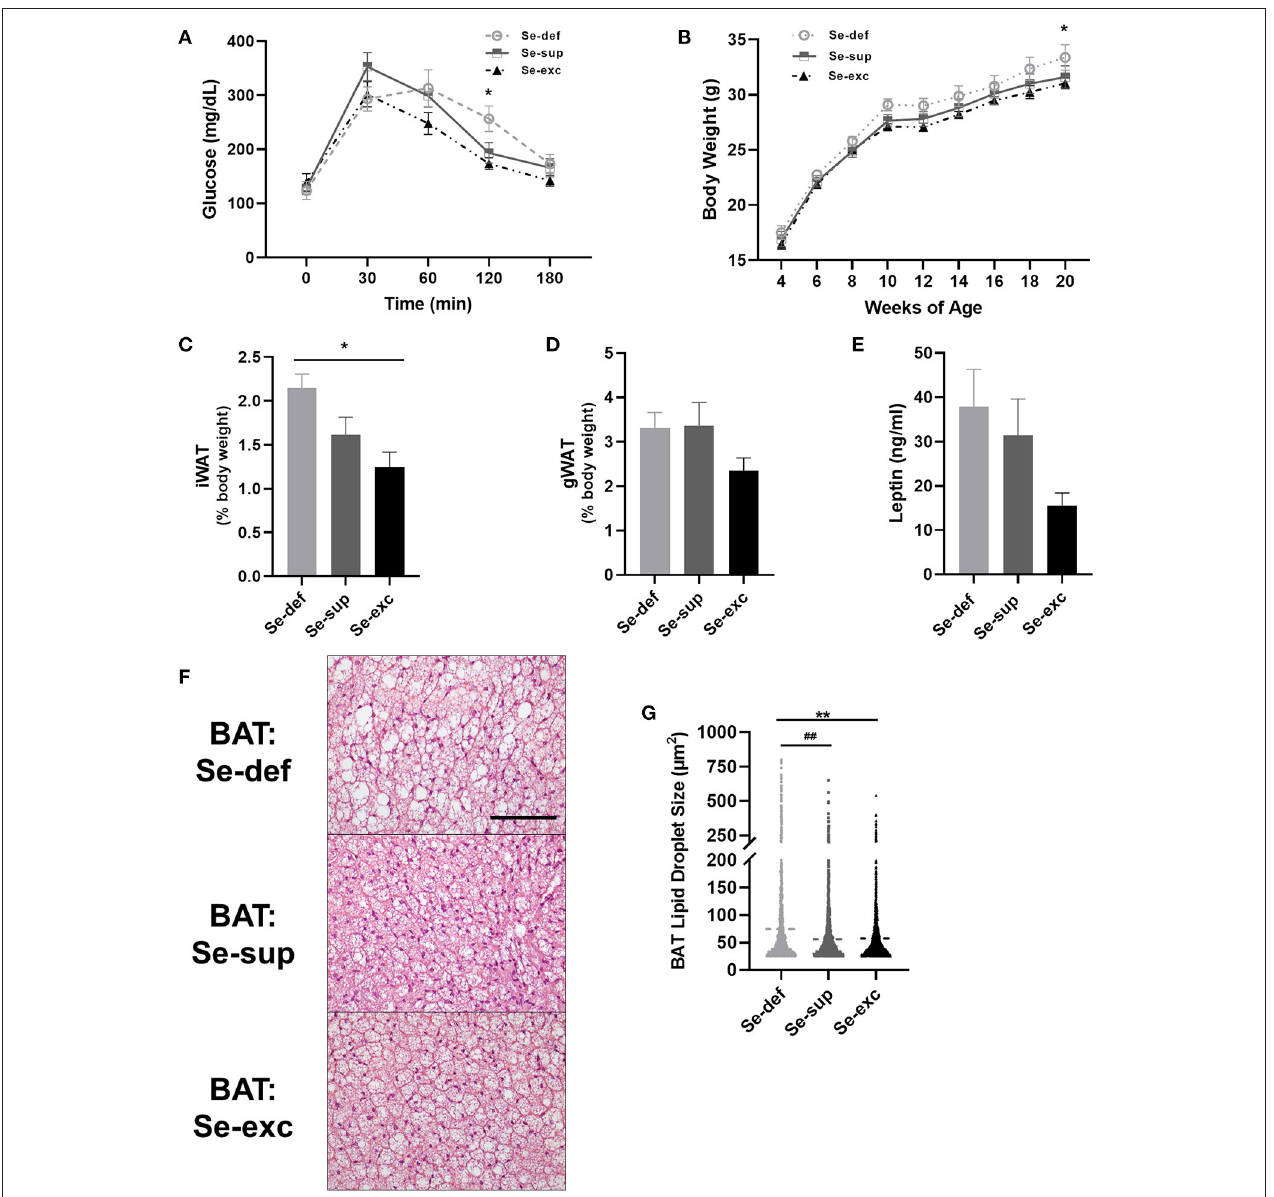
FIGURE 3 | Impaired glucose tolerance and increased adiposity in Se-deficient mice. (A) Mean ( ± SEM) blood glucose levels during glucose tolerance testing ( n = 7–8 per group). (B) Mean ( ± SEM) body weight from 4 to 20 weeks of age ( n = 9–10). (C) Mean ( ± SEM) inguinal white adipose tissue ( n = 4). (D) Mean ( ± SEM) gonadal white adipose tissue relative to total body weight ( n = 4). (E) Mean ( ± SEM) serum leptin levels ( n = 7–9). (F) Representative images of brown adipose tissue (BAT). (G) Scatter plot of BAT lipid droplet size ( n = 4). Scale bar = 100 µ m, * p < 0.05 between Se-exc and Se-def groups, ** p < 0.01 between Se-exc and Se-def groups; ## p < 0.01 between Se-def and Se-sup